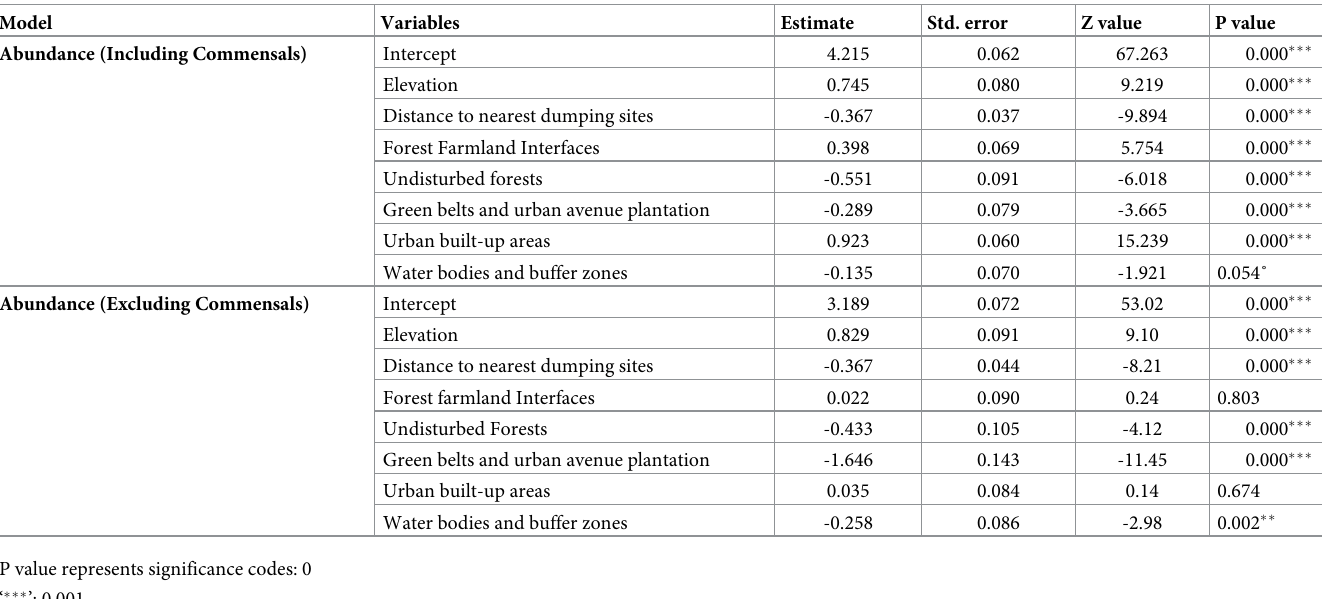
Table 4. Generalized linear model (GLM) explaining relationship between raptor abundance and habitat characteristics. Two models, one that included the com- mensals M . migrans and M . m . lineatus and second, excluding them, were run to analyze effect of habitat variables on raptor abundance.